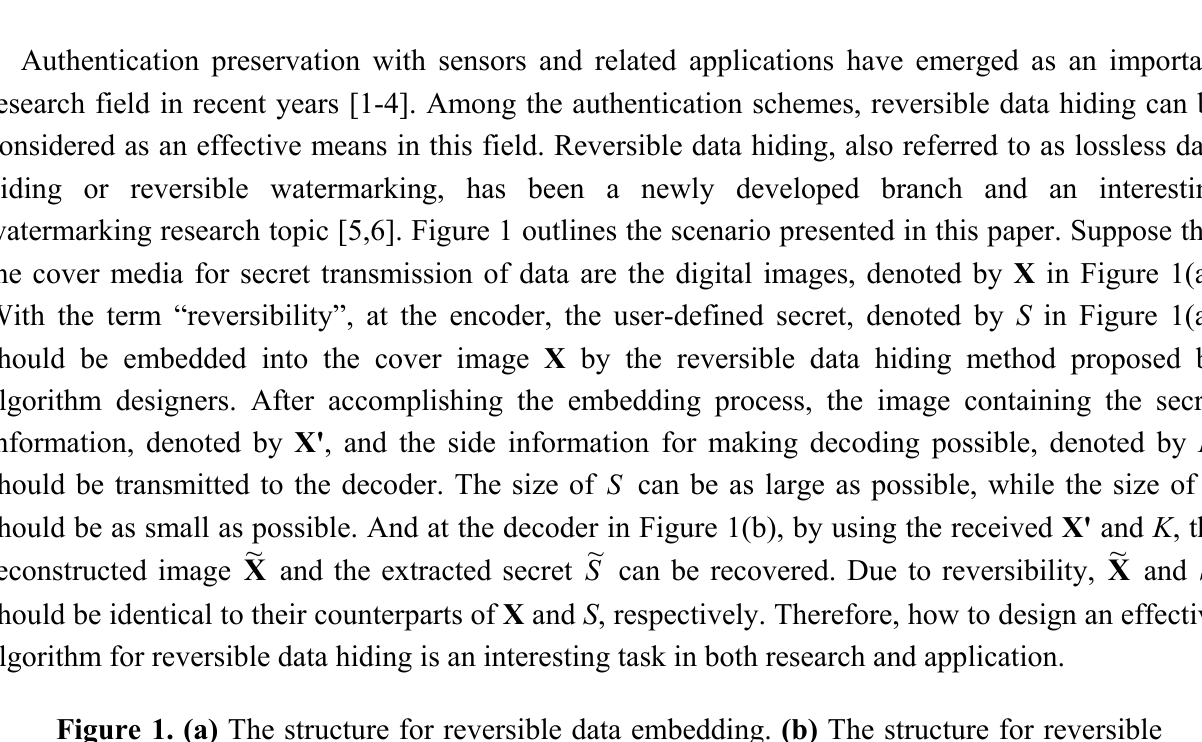
Figure 1. (a) The structure for reversible data embedding. (b) The structure for reversible data